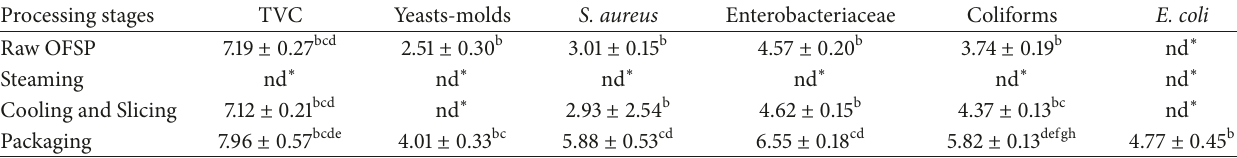
Table 9: Microbial counts of OFSP at different stages of processing in OFSP puree processing plant 1 (log Mean CFU/g). Processing stages